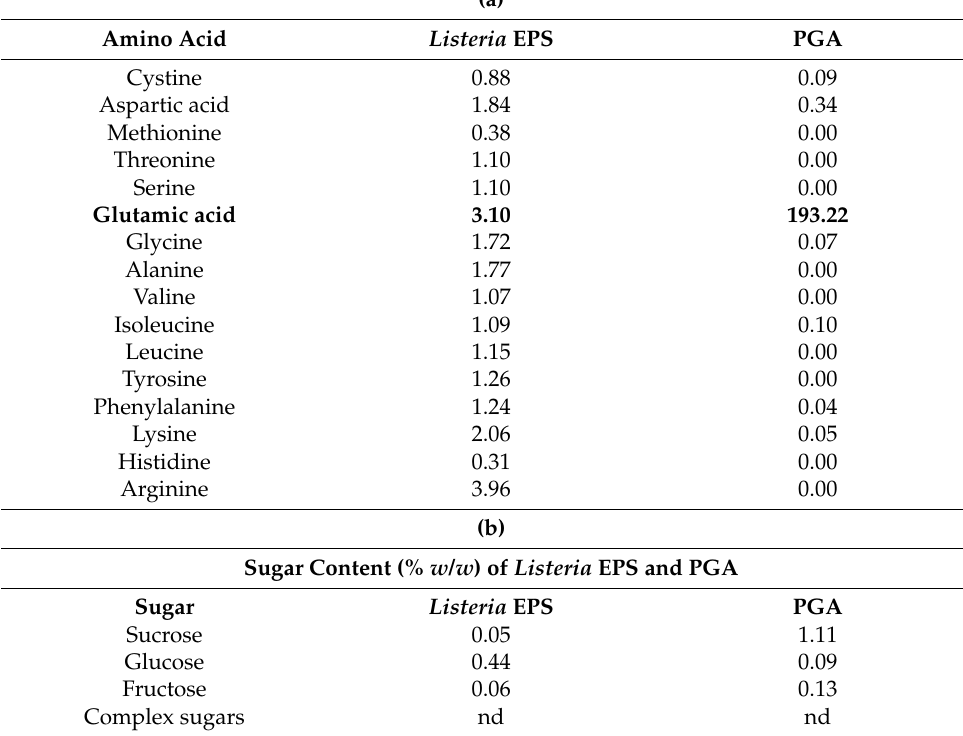
Table 1. Amino acid content (g kg − 1 ) of the Listeria EPS without pronase treatment compared with the amino acid content of poly-gamma-glutamic acid (PGA). Commercial PGA (Vedan, Taiwan) was used for comparison.